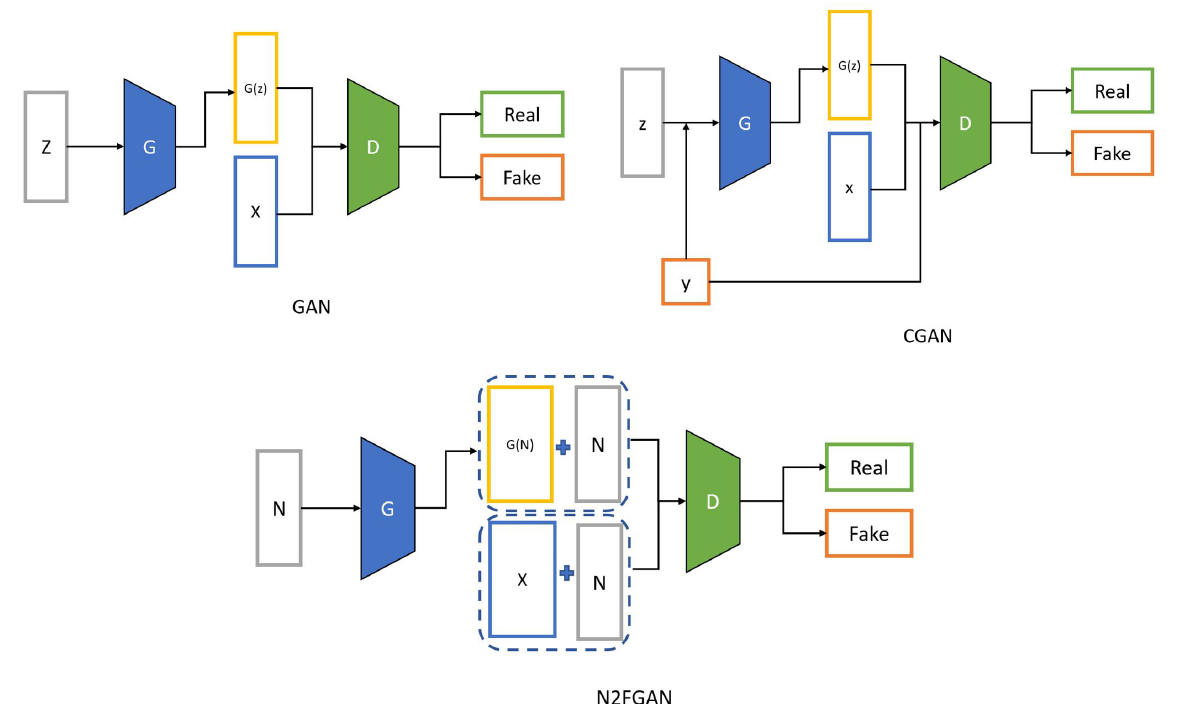
Figure 4. A comparison between GAN, CGAN, and our proposed